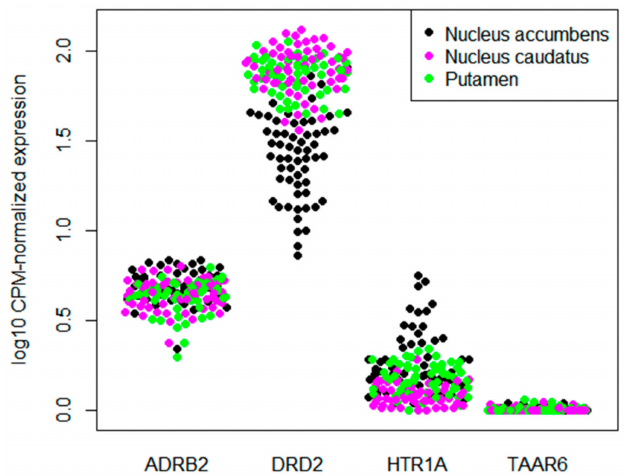
Figure 2. Expression levels of TAAR6, DRD2, ADRB2, and HTR1A in the human basal ganglia (dataset GSE160521).